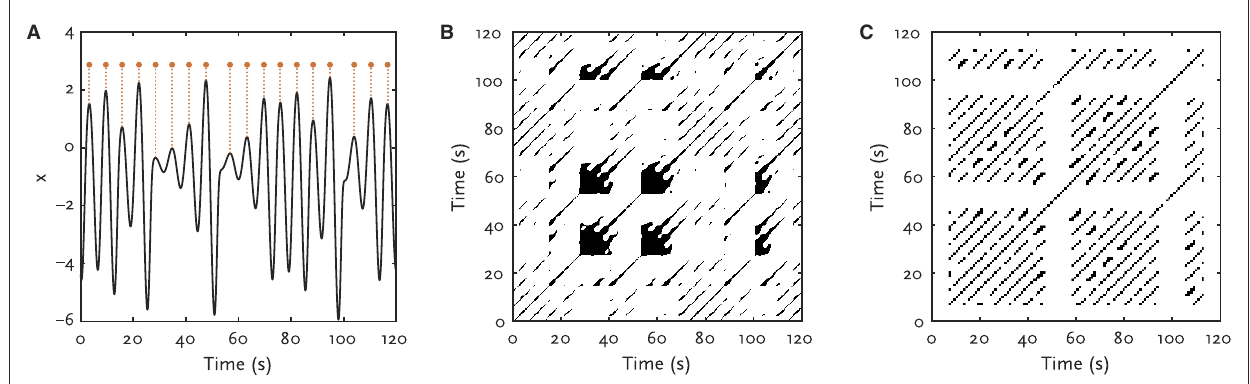
FIGURE2 Example of a recurrence plot using edit distance. (A) The maxima (red dots) of the x -variable of the Rössler system [45] are used to mimic sparse (or extreme) events. (B) Recurrence plot calculated from the ( x , y , z )-variables of the Rössler system. (C) Recurrence plot derived from the events in (A) using the edit distance as defined by Equation (3). Periodical occurrence of the events are clearly indicated by the period line structures in the edit distance recurrence plot. The empty bars around t = 55s and t = 100s indicate the parts in the dynamics with abrupt changes where no maximum values appear. Edit distance is calculated using overlapping windows length T w = 15s and moving step of s = 1s. The recurrence threshold ε is selected to ensure a recurrence rate (recurrence point density) of